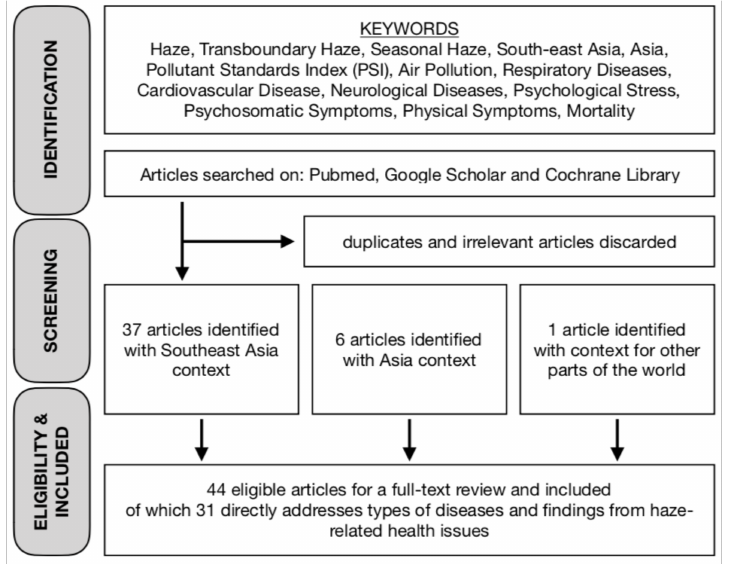
Figure 1. Flowchart of paper selection.